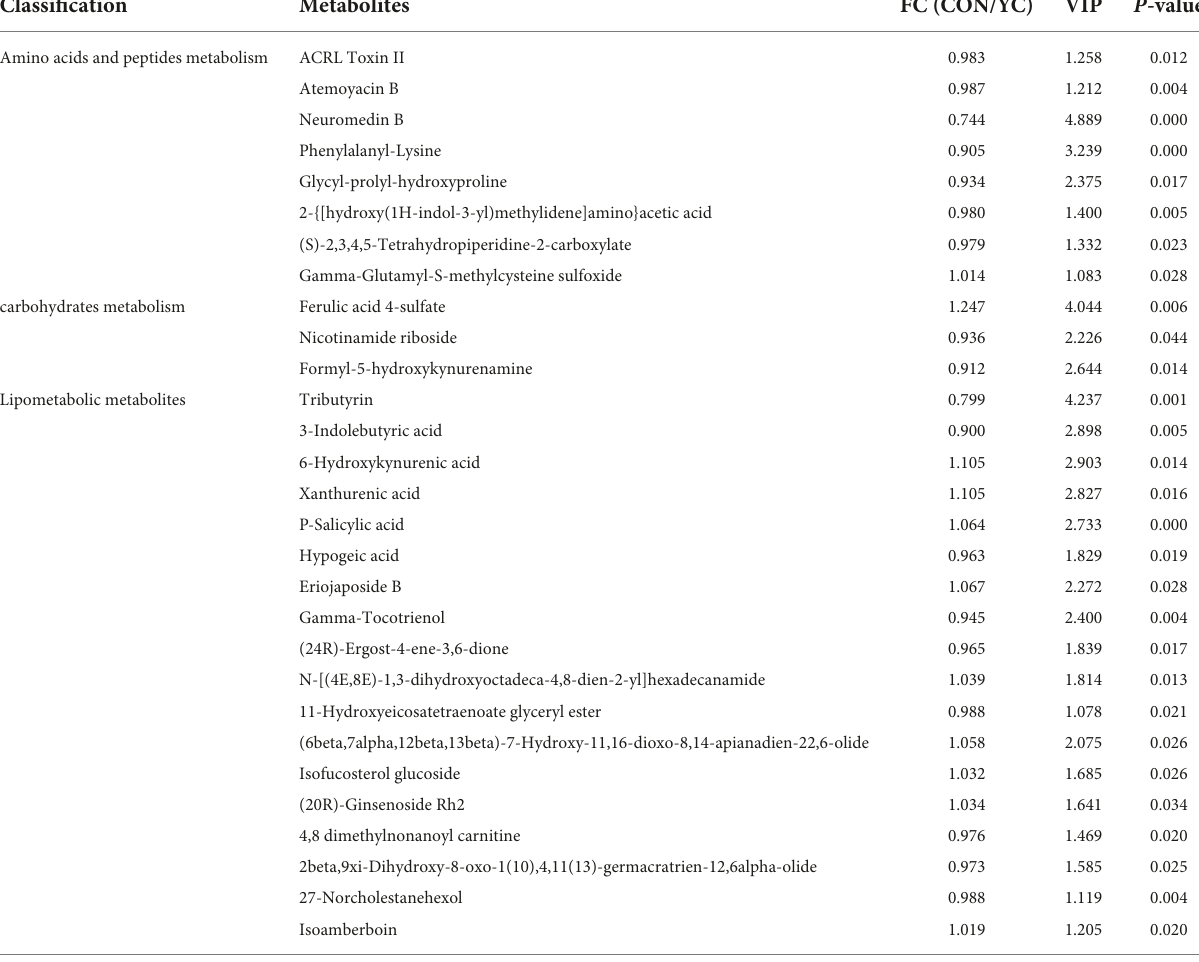
TABLE 5 Different metabolite contents in the rumen of bulls fed a control diet (CON) vs. bulls fed 40 g/day of